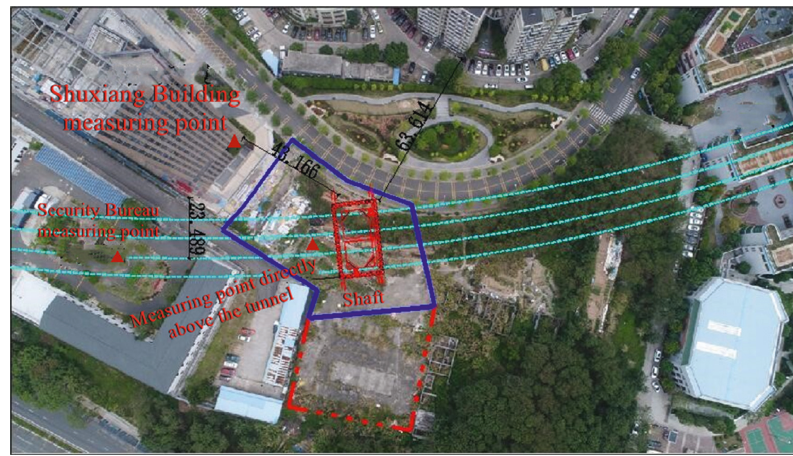
Figure 1: Location of on-site monitoring